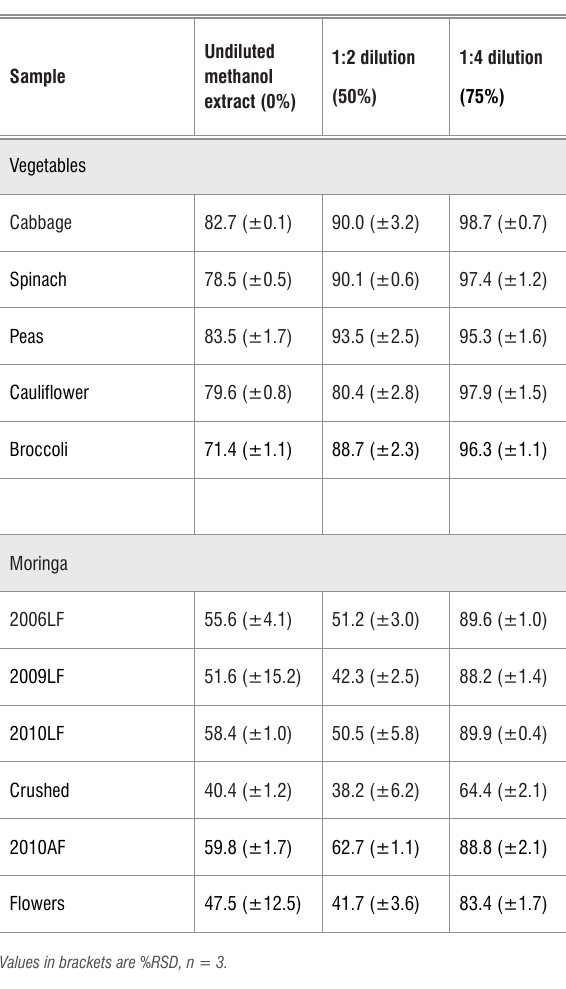
Table 2: Percentage DPPH · radicals remaining after 60 min of incubation with Moringa oleifera and vegetable extracts at three different solvent concentrations